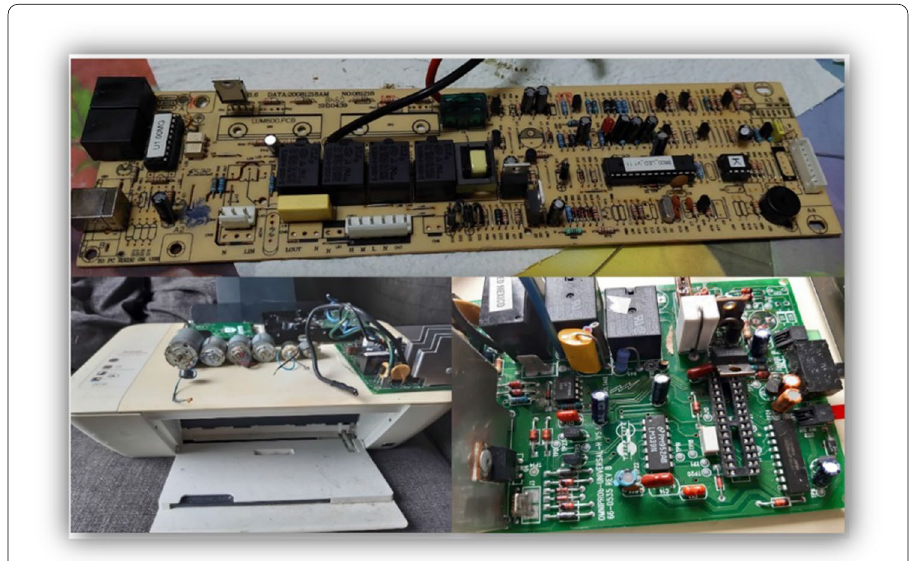
Fig. 4 Above, the motherboard of an uninterruptible power supply (UPS). Bottom left, a printer with typical motors recovered from this equipment and next to it, the board of an audio amplifier—all equipment discarded due to malfunction or end of